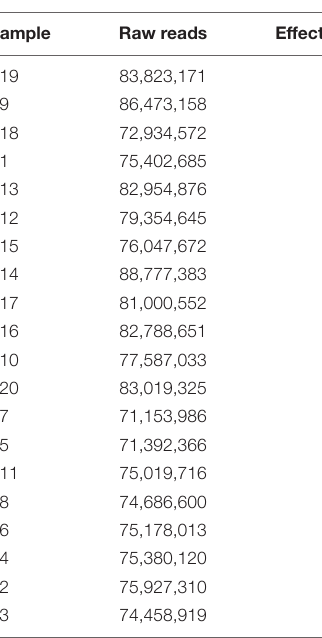
TABLE 1 | Summary statistic of resequencing